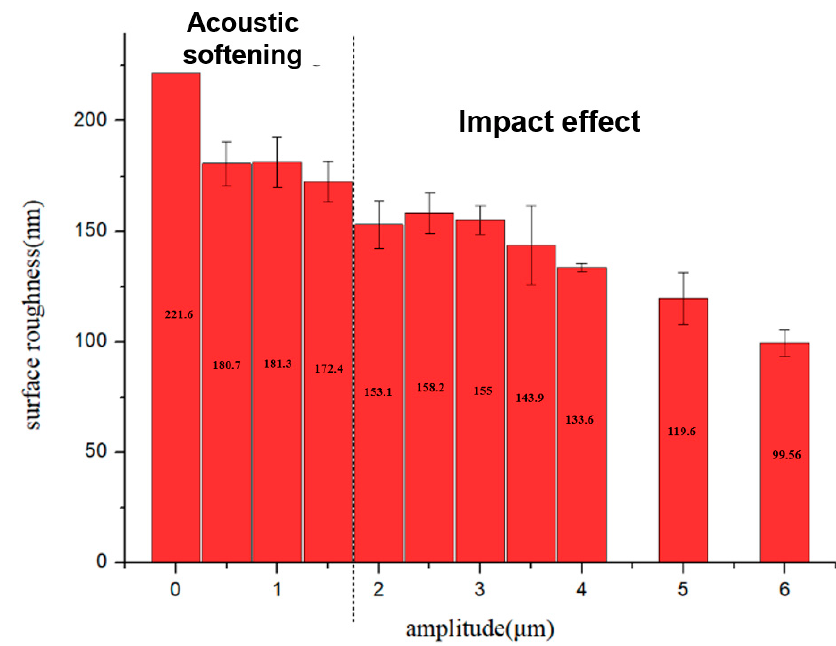
Figure 10. The average surface roughness at different amplitudes.